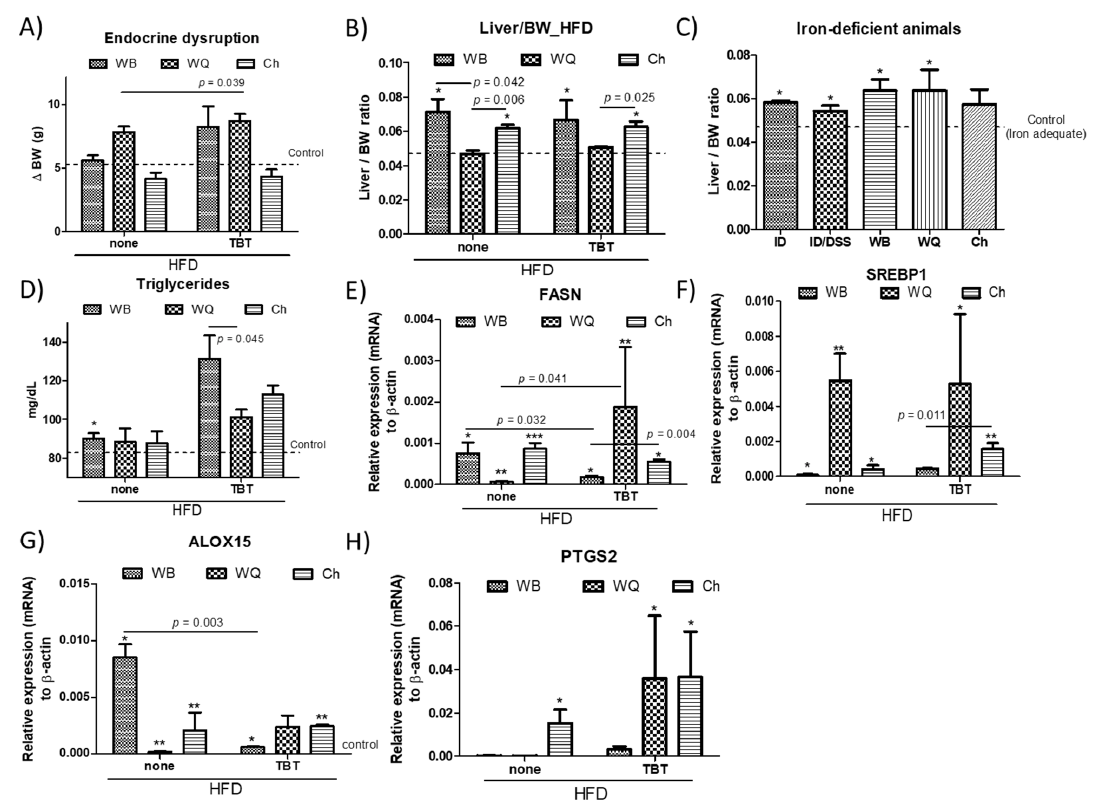
Figure 3. Effects of bread formulations-WB, wheat bread; WQ, white quinoa flour (25%)–containing bread; Ch, chia flour (20%)–containing bread-on body weight (BW) gain ( A ), changes in the hepatosomatic index (Liver/BW ratio) in wild type and tributyltin-exposed mice ( B ) as well as iron deficient mice ( C ), plasmatic triglyceride concentrations ( D ), and transcript levels (mRNA) of lipogenic markers-fatty acid synthase (FASN) ( E ) and sterol regulatory element-binding protein 1 (SREBP1a) ( F ), and coronary risk markers-arachidonate 15-lipoxygenase (ALOX15) ( G ) and prostaglandin-endoperoxide synthase (PTGS2) ( H ). Results are expressed as mean ± mean standard error ( n = 3–6). Untreated controls are represented by the dotted line. *, **, *** indicates statistical differences between animals put under the same experimental